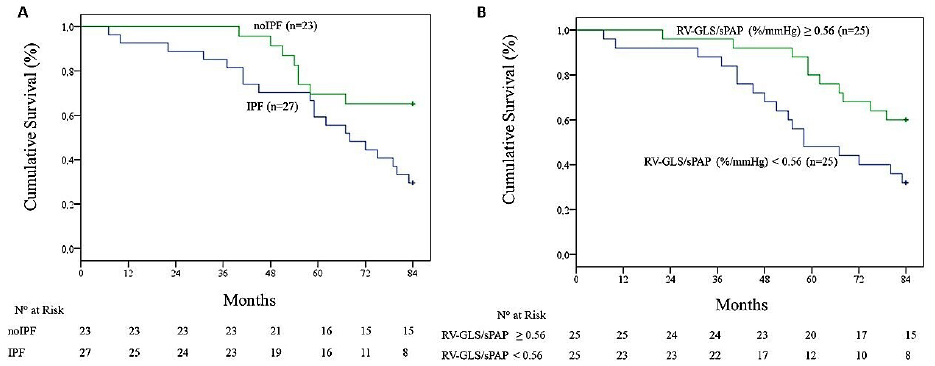
Figure 2. ( A ) Kaplan–Meier curves representative of the cumulative survival of idiopathic pulmonary fibrosis (IPF) patients vs. those with fibrotic interstitial lung diseases other than IPF (here reported as non-IPF). ( B ) Kaplan–Meier curves representative of the cumulative survival of the whole study population according to the right ventricle (RV) coupling to the pulmonary circulation, estimated as the ratio between the RV global longitudinal strain (RV GLS) and the systolic pulmonary artery pressure (sPAP).